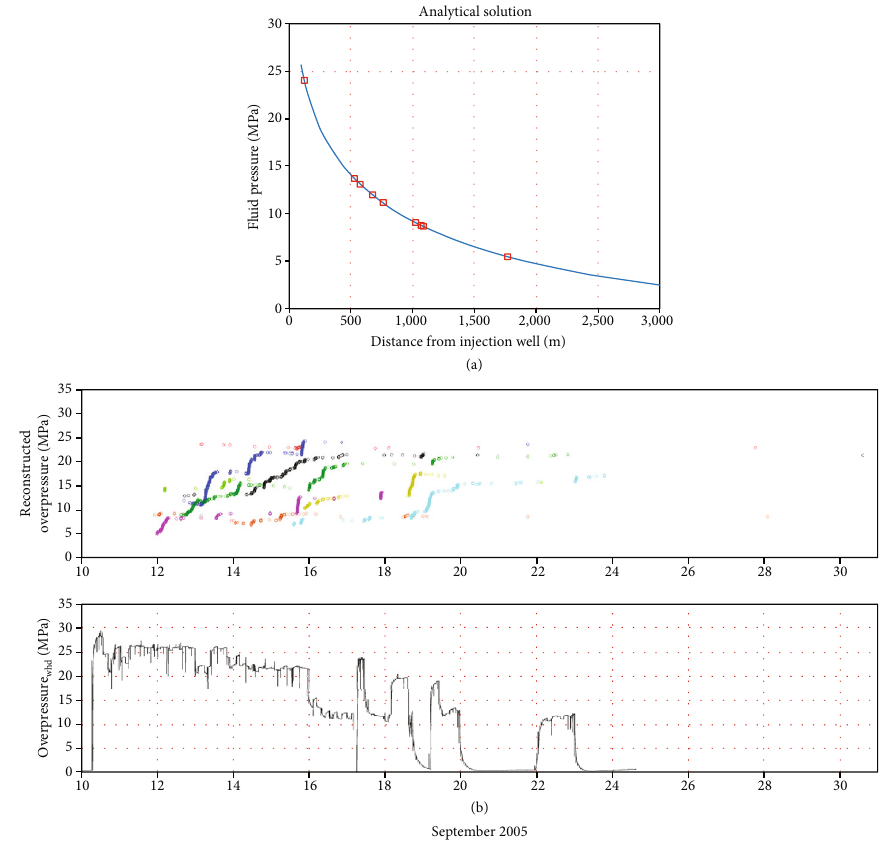
Figure 14: (a) Analytical solution [25] for pressure resulting from injection into an in fi nite fault with homogeneous properties. Parameters were selected to approximate the initial 2003 stimulation. Homogeneous fault transmissibility of T = 0 : 11 Dm and a constant injection rate of 25l/s are assumed. The spatial pressure distribution is shown after 11.5 days. Red squares denote the distance of the 9 reference points and the associated pressure level which is assumed to equal the level P ( r ) at which further seismicity can occur. (b) Same as Figure 13 while absolute 0 overpressure is reconstructed by adding the initial pressure P 0 ð r Þ to Δ P SHPM